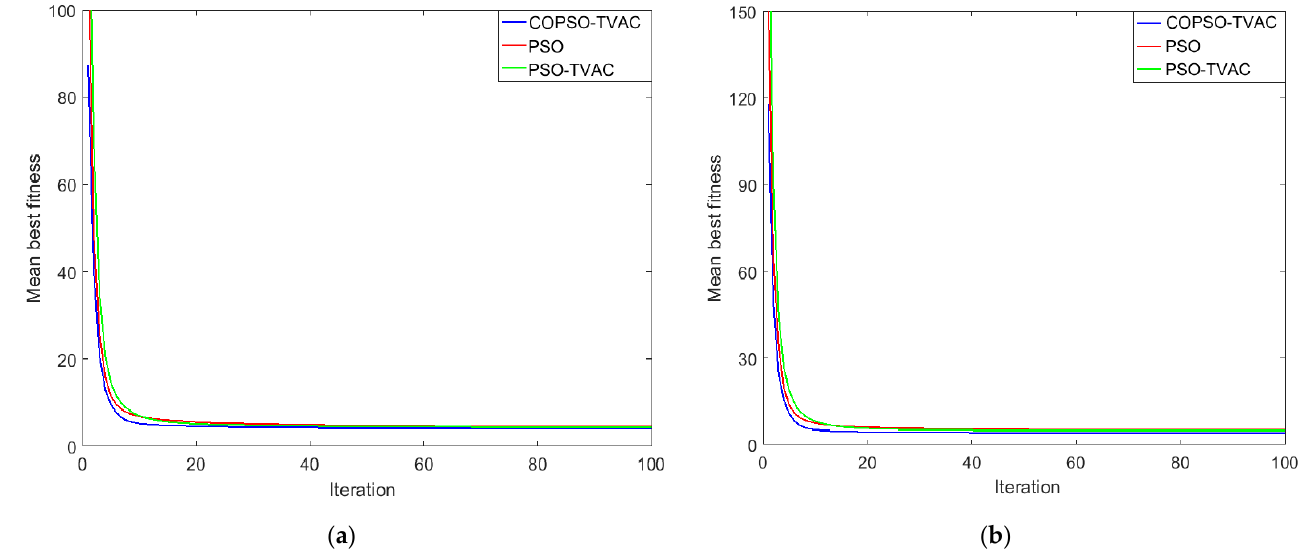
Figure 8. The convergence properties of the proposed metaheuristic algorithms in the scenario with 2 NLOS BSs: ( a ) the suburban environment; ( b ) the urban environment.